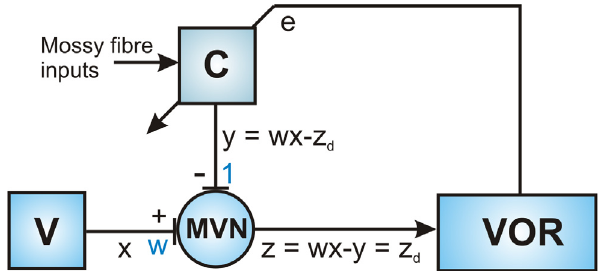
Figure 11. Effect of LTP/LTD imbalance: Modeling brainstem learning in the closed loop. The vestibular and cerebellar input signals x , y are coded stochastically as modulations of tonic firing rates m x , m y . When LTP exactly balances LTD the contribution to weight changes from the mean firing rates is zero. Any imbalance however produces an additional term in the learning rule, proportional to the product of the mean firing rates. In the open loop (i.e. when VOR inaccuracy has no effect on the system) this term would tend to drive the weight w to saturation (for an excess of LTP) or to silence (for an excess of LTD). Hence any LTP/LTD imbalance, however small, potentially leads to learning instability. This situation is modified when the behavioural closed-loop via the cerebellum is considered. Whereas error in w is generated at the slow time-scale of brainstem learning,